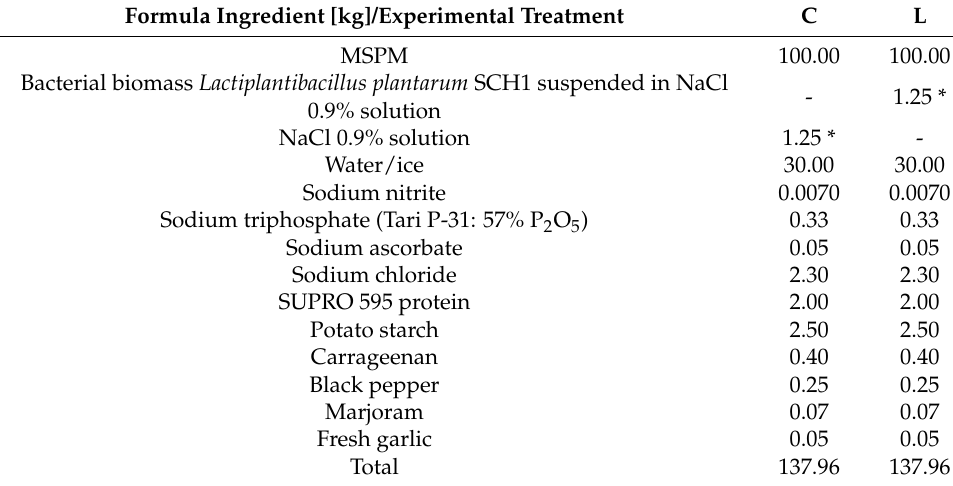
Table 1. Model sausage with the MSPM formula. Formula Ingredient [kg]/Experimental